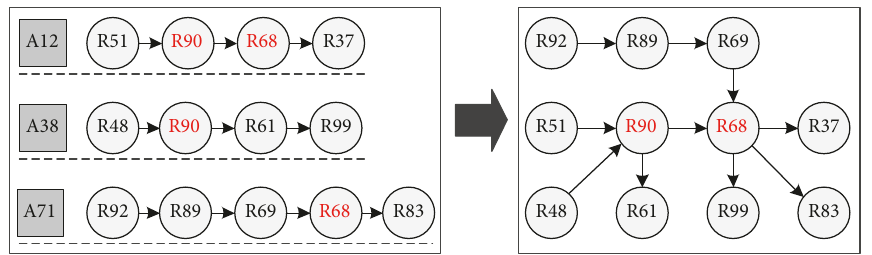
Figure 4: The formative process of CMRN.